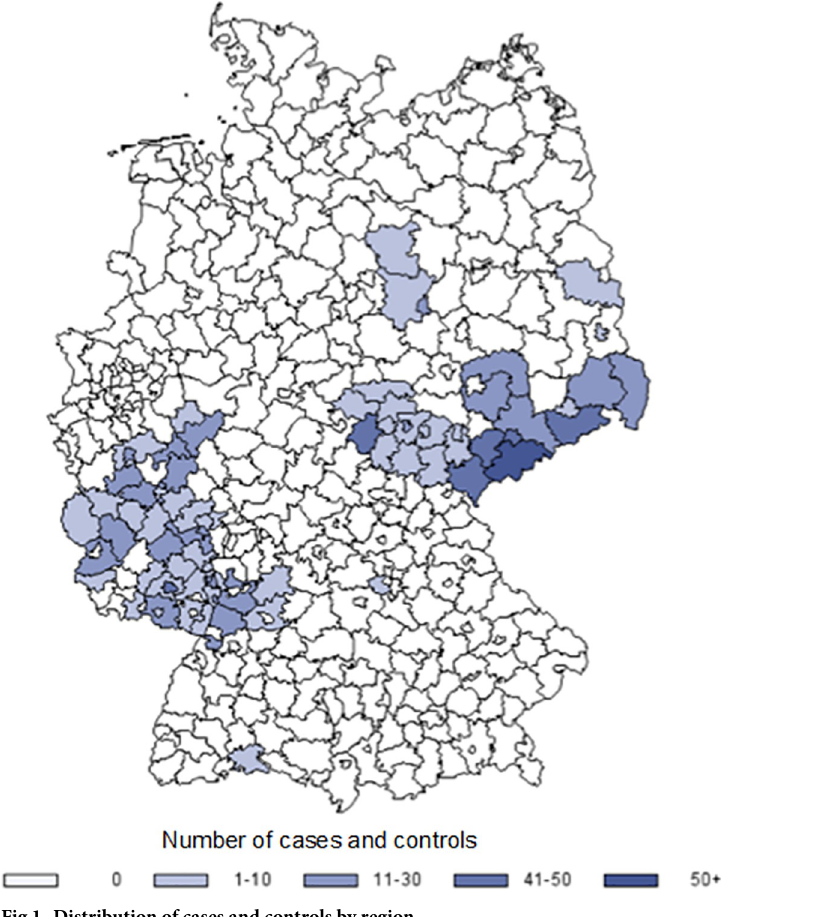
Fig 1. Distribution of cases and controls by